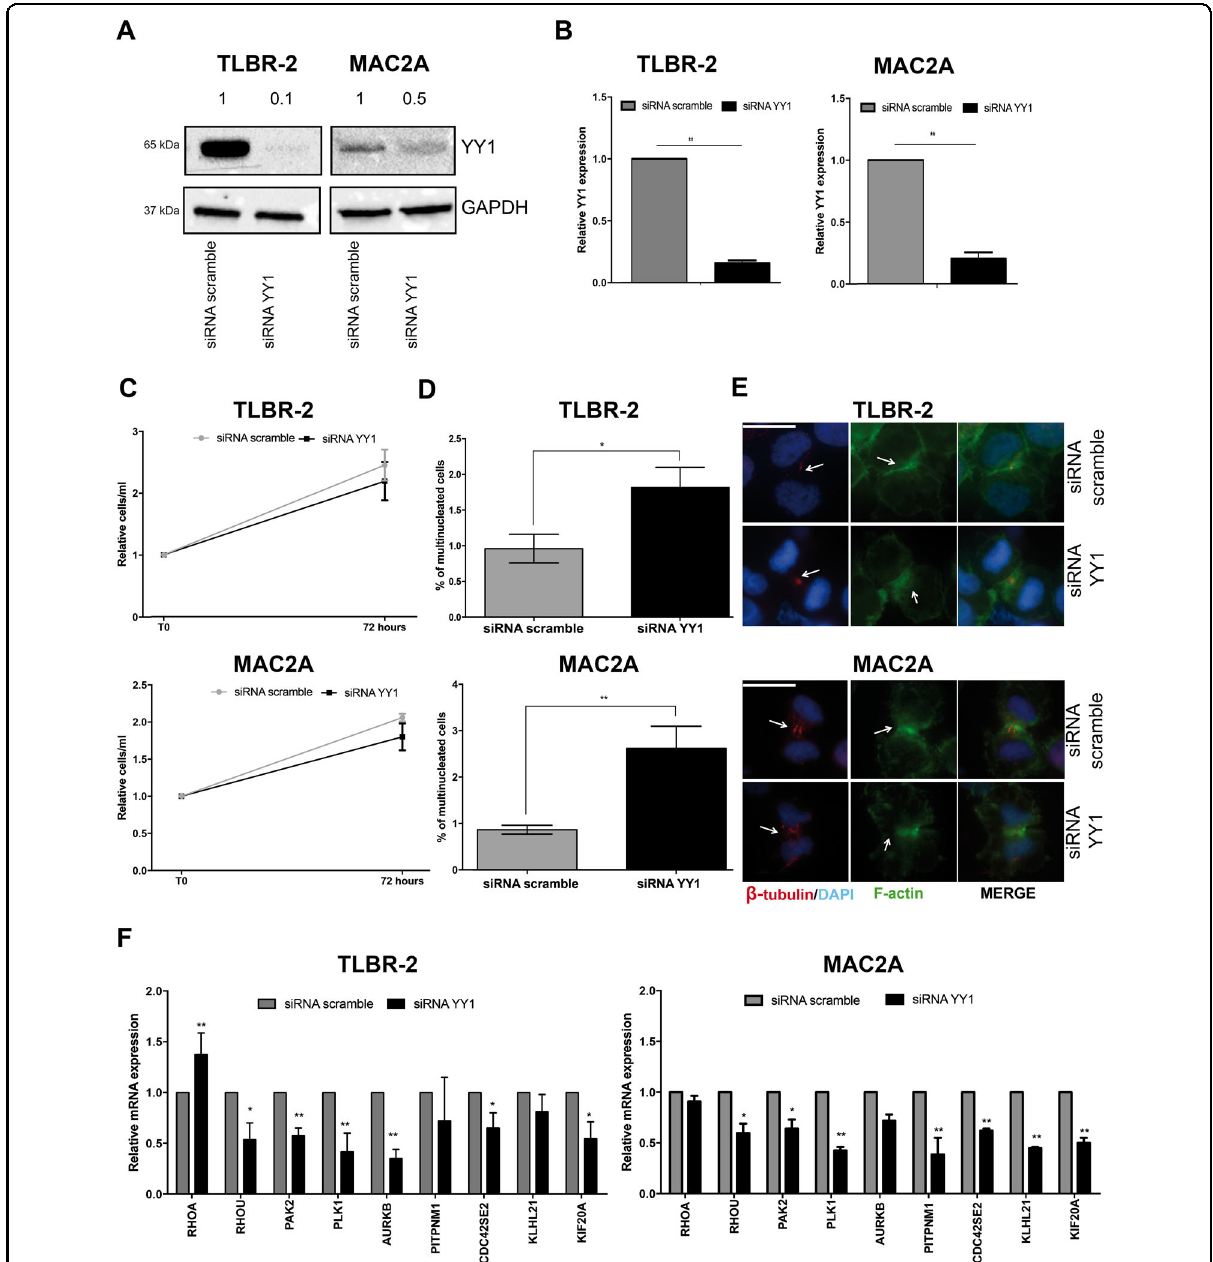
Fig. 4 YY1 cooperates with HELLS to regulate the multi-nucleated phenotype. A Western Blot shows the knockdown of YY1 36 h post- nucleofection with a speci fi c siRNA in TLBR-2 and MAC2A. GAPDH was used as housekeeping gene. B qRT-PCR analysis of YY1 expression after siRNA in TLBR-2 and MAC2A cell lines (36 h post-nucleofection). Each data represent mean ± SEM ( n = 3). Two-tailed t -test. ** p < 0.01. C The graph represents the relative growth curve of TLBR-2 and MAC2A 72 h post-nucleofection with YY1 speci fi c siRNA. Data were normalized on siRNA scramble values. Each data point represents the mean ± SEM ( n = 3). Two-tailed t -test . D . The panels show the percentage of multi- nucleated cells in at least 500 cells stained with β -tubulin and F-actin antibodies (48 h post-nucleofection). Each data point represents the mean ± SEM ( n = 3). Two-tailed t -test. * p < 0.05; ** p < 0.01. E Panels show representative immuno fl uorescences of TLBR-2 and MAC2A stained with DAPI, F-actin, and β -tubulin antibodies 48 h post-nucleofection. The scale bar represents 10 μ m. F qRT-PCR analysis of a panel of selected HELLS-target genes in TLBR-2 and MAC2A 36 h post-nucleofection with speci fi c YY1 siRNA. The values represent mean ± SEM ( n = 3). Two-tailed t -test. * p < 0.05; ** p <